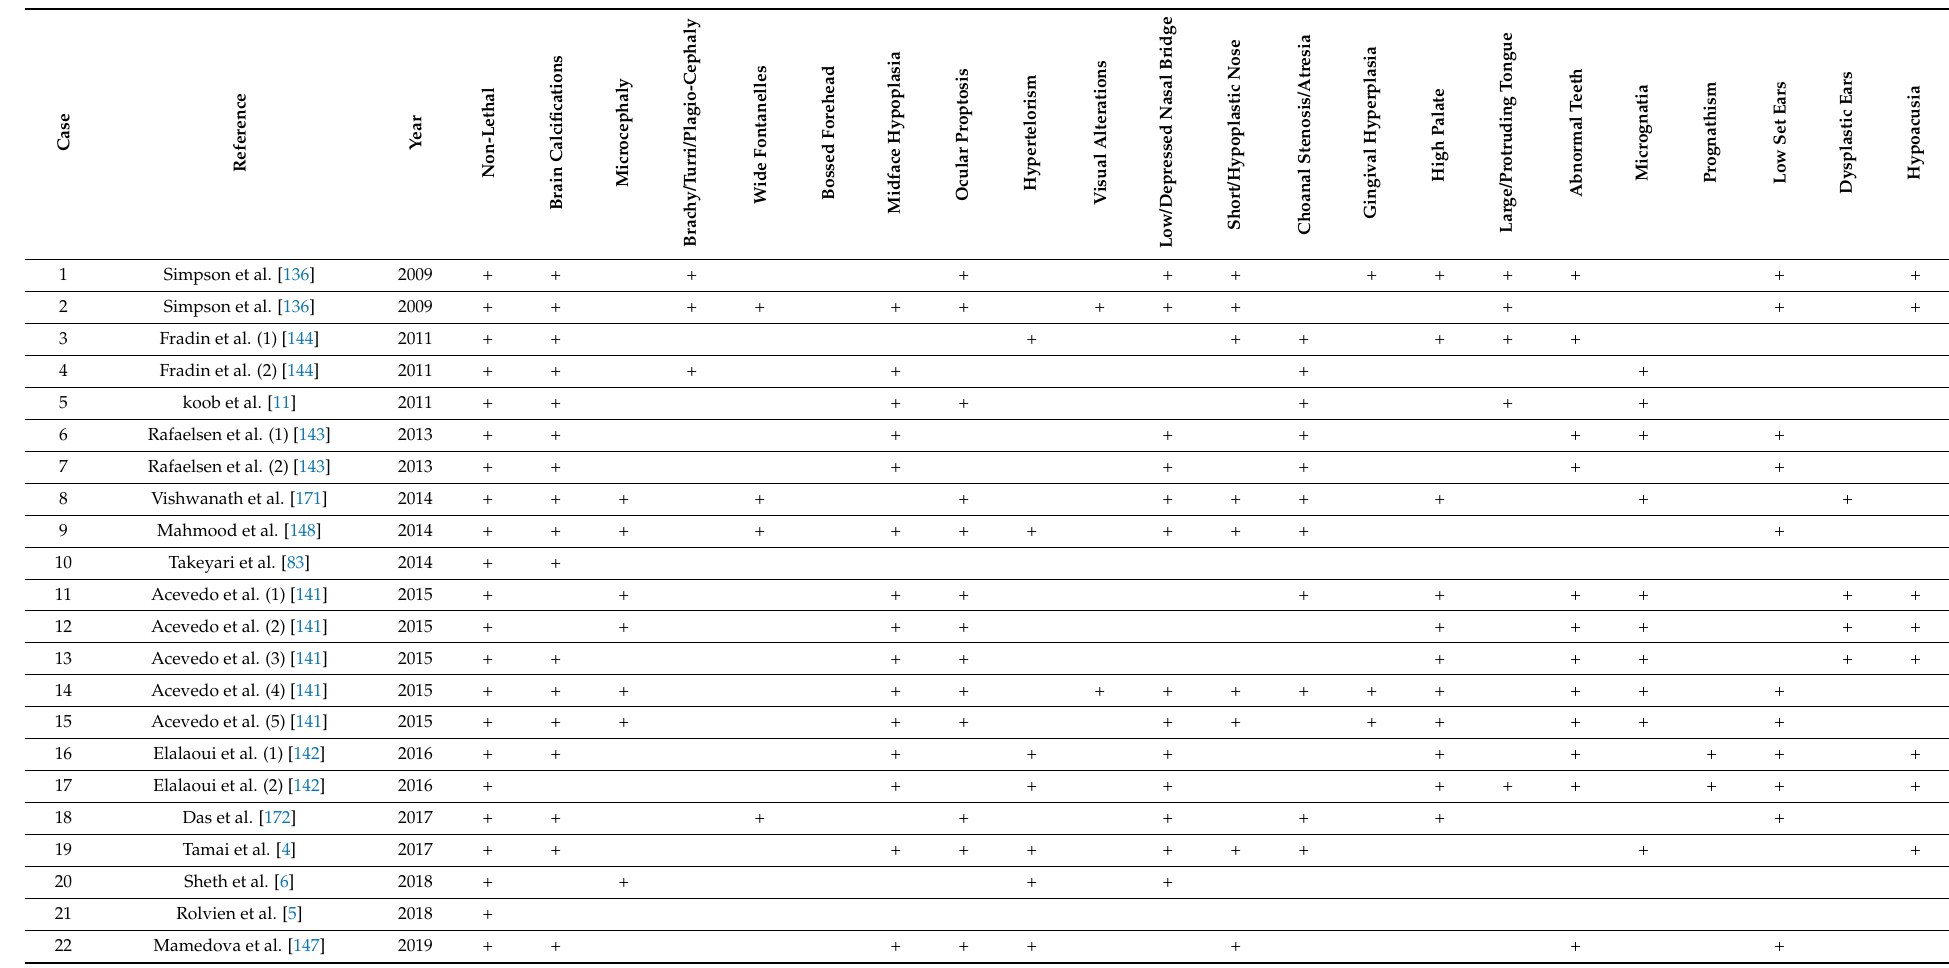
Table 5. Craniofacial features of non-lethal lethal